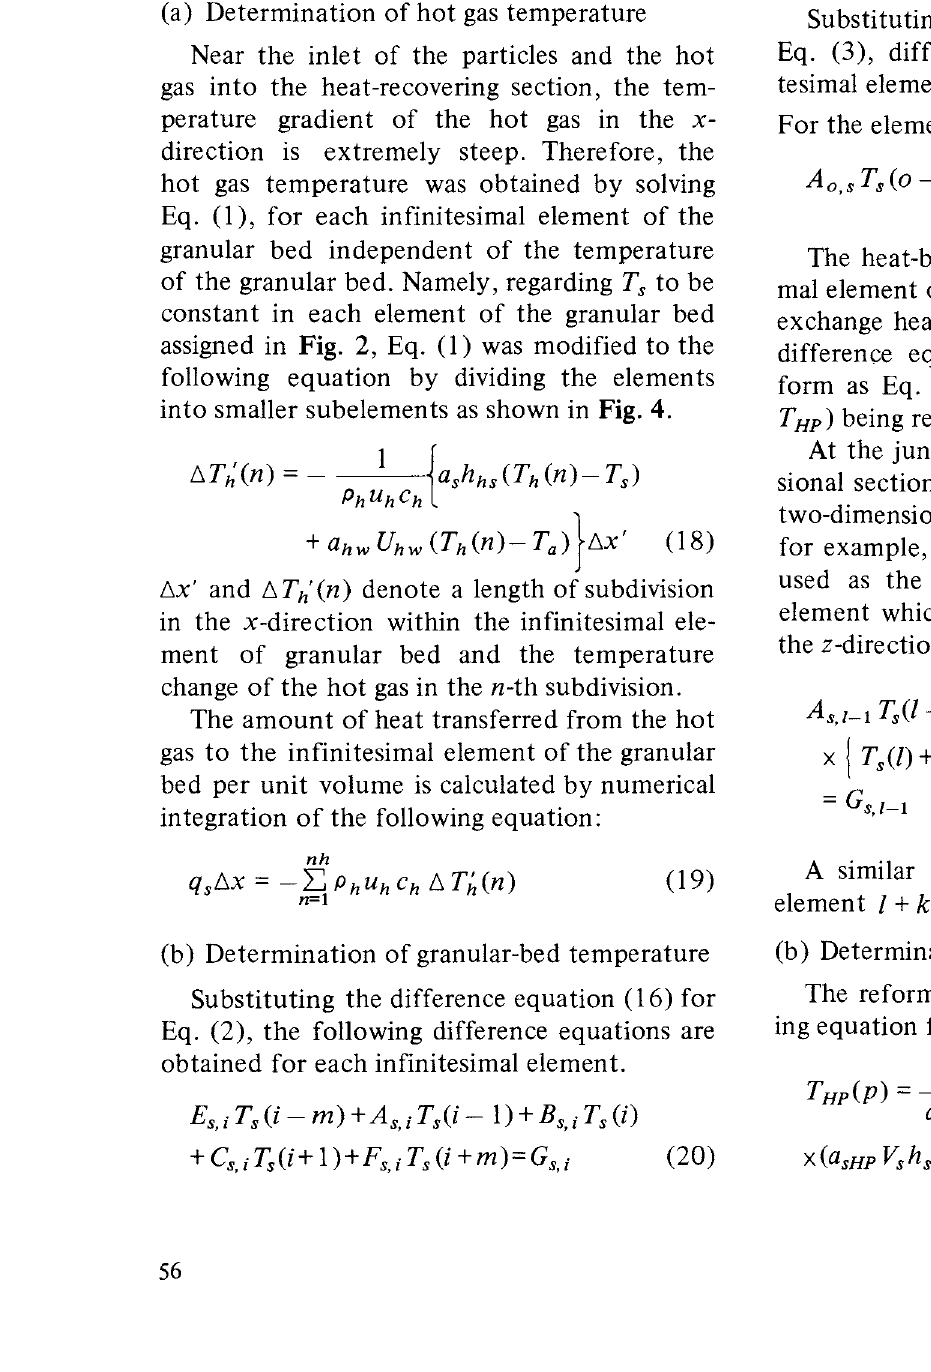
Fig. 4 Temperature distribution of the hot gas within an infinitesimal element of the granular